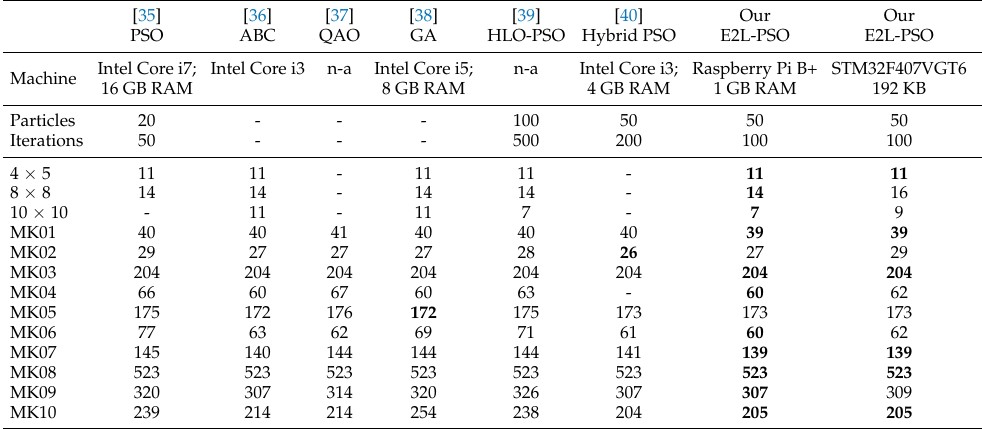
Table 15. Comparison of the E2L-PSO against other works (non PSO-based and PSO-based